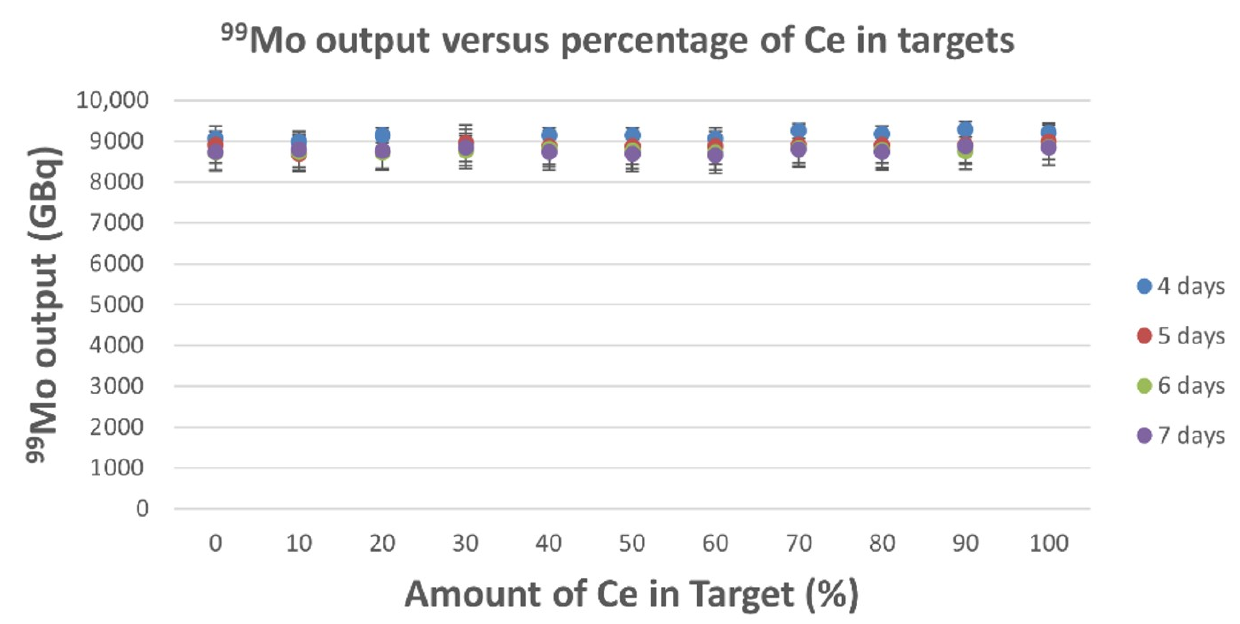
Figure 3. How the sustainability index varies with increasing amount of Ce in targets with 4 days irradiation. The 99 Mo output of the 4 target types is given in Figure 4.